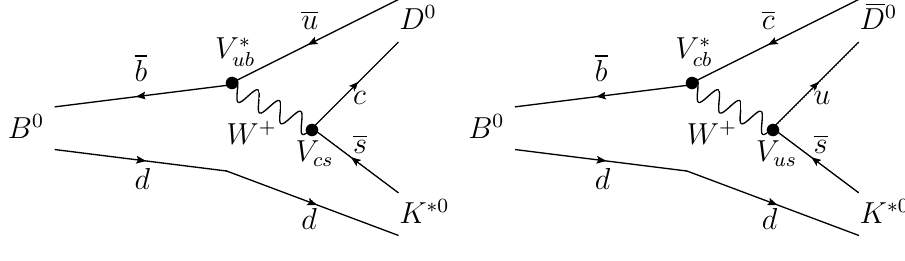
Figure 1 . Feynman diagrams of (left) B 0 ! D 0 K (cid:3) 0 and (right) B 0 ! D 0 K (cid:3) 0 .